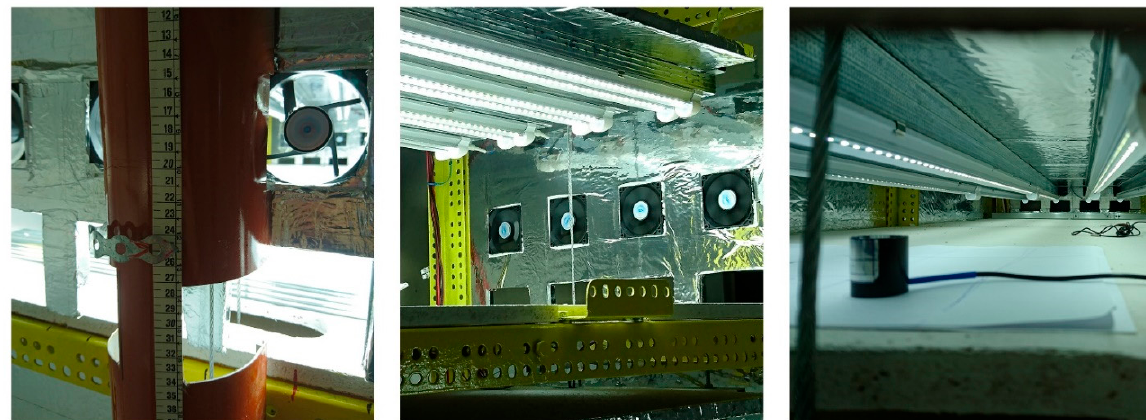
Figure A1. Constriction of the Photon Rack (PR) system at K.Dekoulis Lab in Kallithea, Athens, Greece.